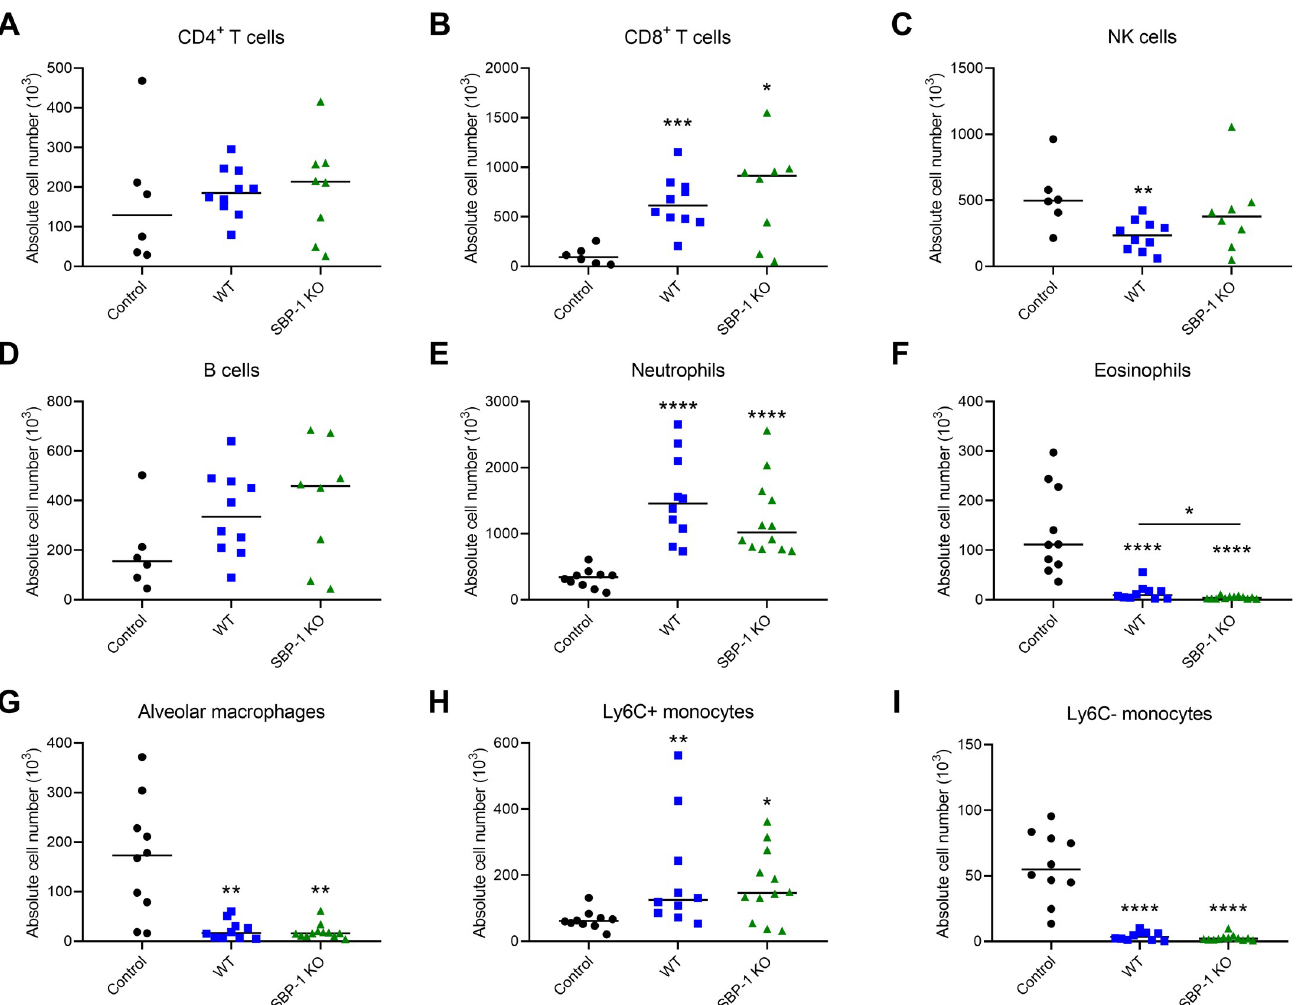
Fig 8. Comparable cell counts of lymphoid and myeloid subsets in lungs of WT and SBP-1 KO infected mice. Flow cytometric analysis at day 8 p.i. of pulmonary lymphoid and myeloid cells. Leukocytes (CD45 + ) were subdivided in (A) CD4 + T cells (CD3 + NK1.1 - CD4 + ), (B) CD8 + T cells (CD3 + NK1.1 - CD8 + ), (C) NK cells (CD3 - NK1.1 + ), (D) B cells (CD3 - NK1.1 - B220 + ), (G) alveolar macrophages (Siglec F + CD11c + ). Myeloid cells (CD3 - CD19 - NK1.1 - ) were subdivided in (E) neutrophils (Ly6G + CD11b + ), (F) eosinophils (Siglec F + CD11c - ), (H) Ly6C + monocytes (CD11b + MHCII - Ly6C + ) and (I) Ly6C - monocytes (CD11b + MHCII - Ly6C - ). Absolute cell numbers for whole lungs are shown. Asterisks above data points indicate significant differences compared to control mice, asterisks above a horizontal line show significant differences between infected groups. Data of two experiments, n = 6–12 per group.